Question: State the chart type depicted above.
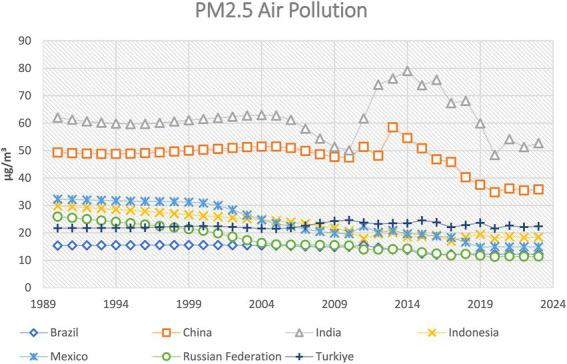
Answer: line